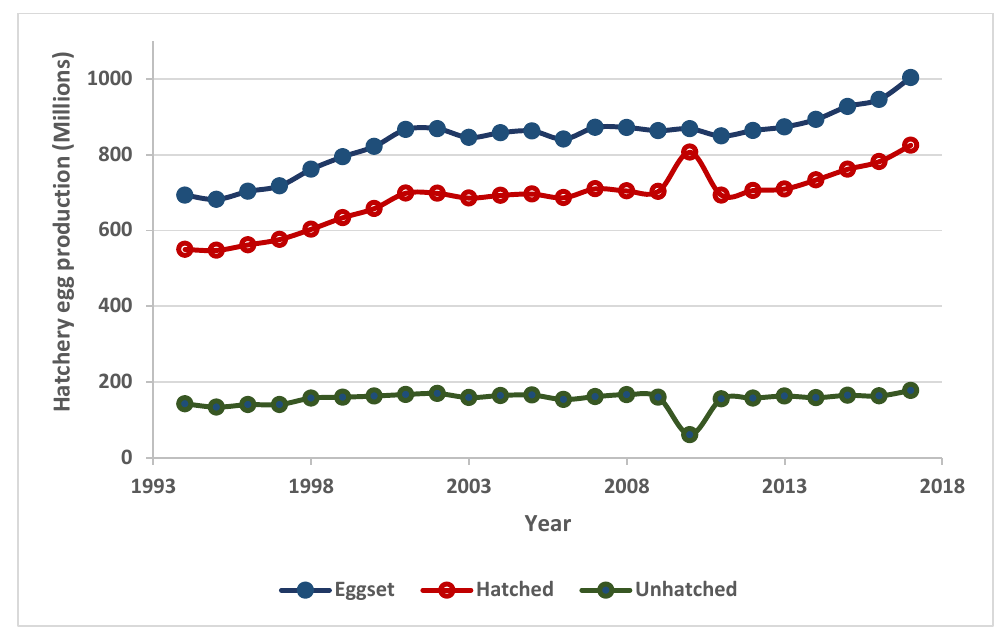
Figure 5. Canadian hatchery egg production from 1994 to 2017.